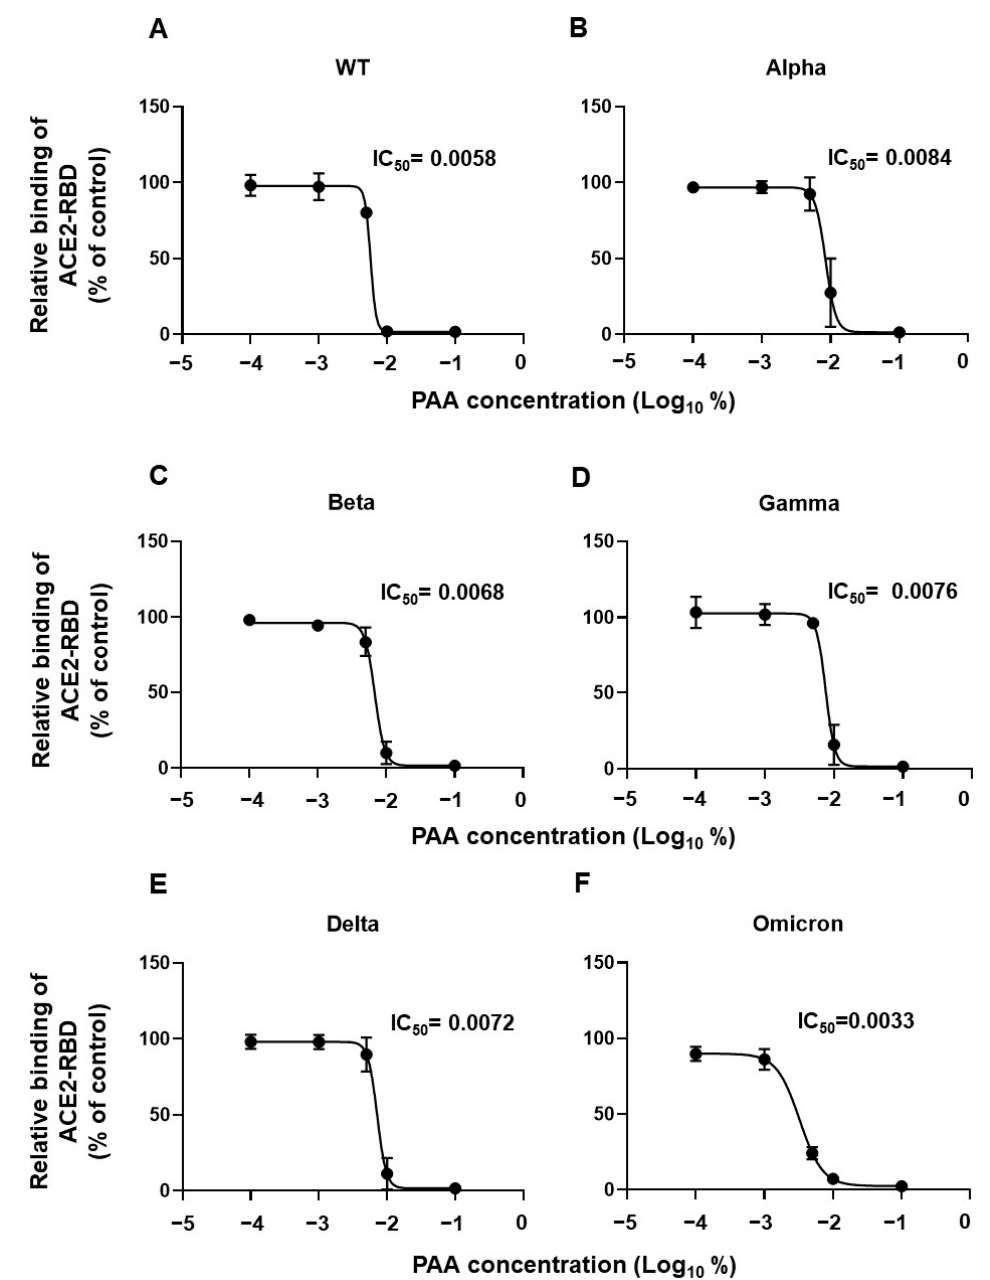
Figure 4. PAA impaired SARS-CoV-2 RBD interaction with ACE2 in vitro. Dose-dependent inhibition of recombinant RBD protein binding to ACE2 by PAA. The recombinant RBD protein was pretreated with PAA for 30 min, and its ACE2 binding was examined using ELISA. ( A ) WT, ( B ) Alpha, ( C ) Beta, ( D ) Gamma, ( E ) Delta, and ( F ) Omicron (BA.1). Experiments were independently repeated three times, and similar results were obtained. The 50% inhibitory concentration (IC50) was calculated using the GraphPad Prism software, version 9.4.1.